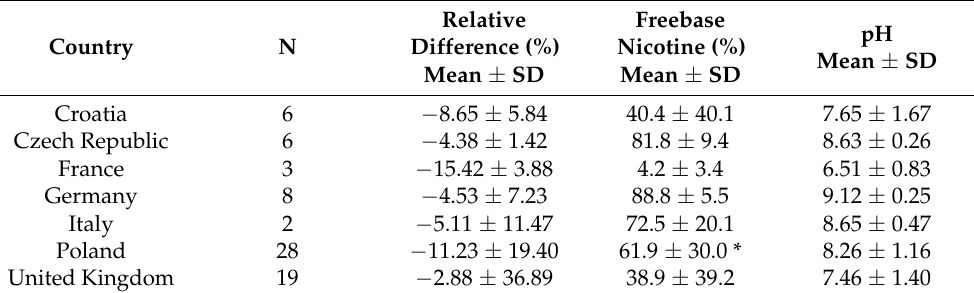
Table 1. Mean difference in nicotine content divided into countries in e-liquids with labeled nicotine level above 0 mg/mL.